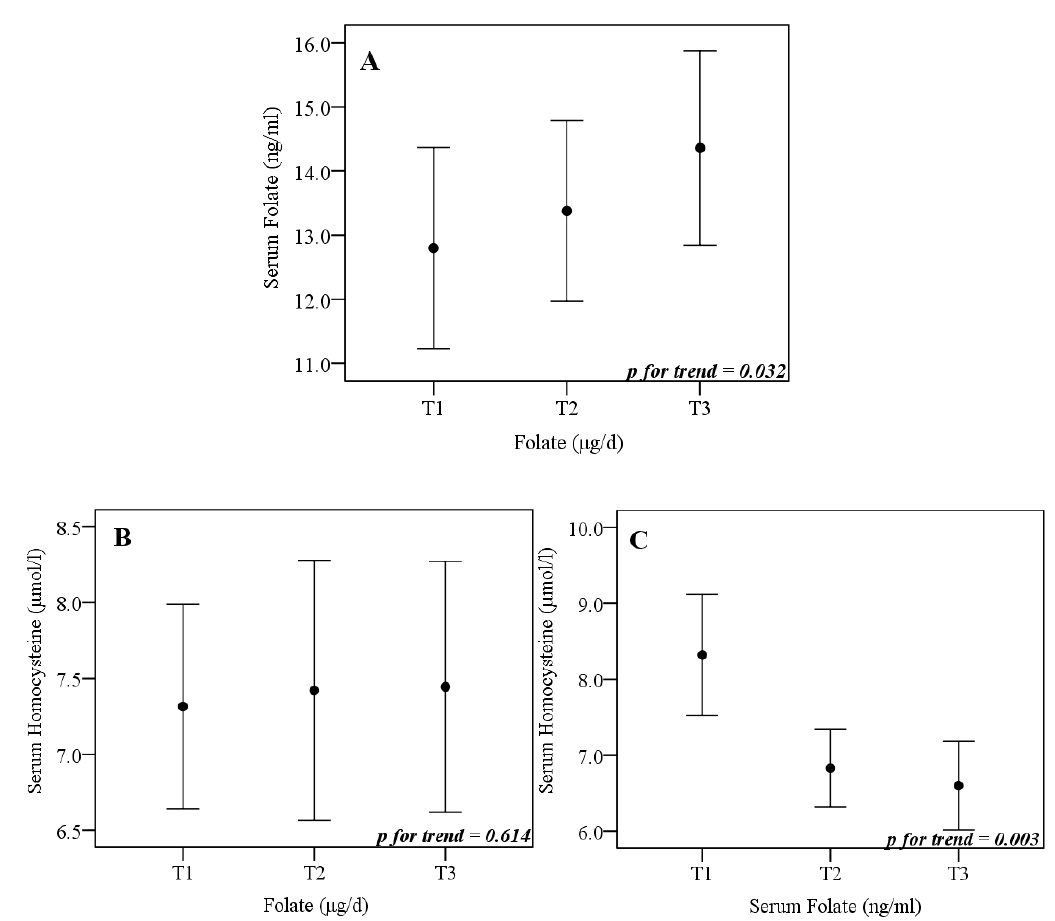
Figure 2. Serum folate and homocysteine values ( A and B ) according to tertiles of folate intake ( n = 92), and homocysteine values ( C ) according to tertiles of serum folate in participants of the face-to-face collect of the CUME project ( n = 110). p for trend in the multiple linear regression model adjusted for sex (male or female) and age (years). A and B: T1 < 414.64; T2 414.64–524.22; T3 > 524.22 µ g/d. C: T1 < 11.32; T2 11.32–15.17; T3 > 15.17 ng/mL.